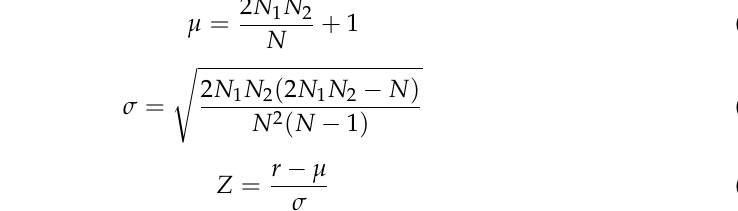
Figure 6. 10-min mean wind speed and direction during Typhoon Sarika. ( a ) 10-min mean wind speed ( b ) 10-min mean wind direction.